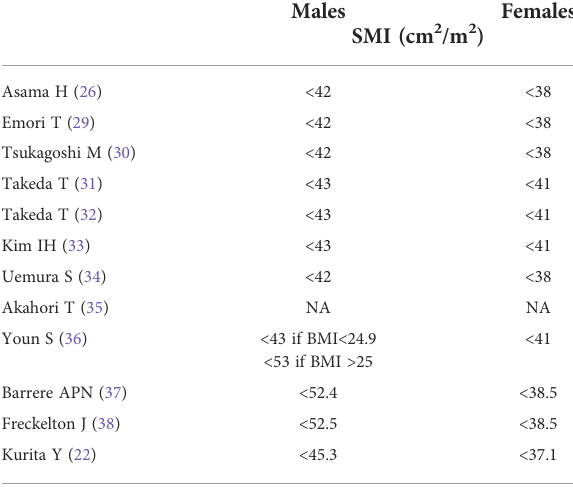
TABLE 2 De fi nition of sarcopenia according to skeletal muscle index in males and females within each included